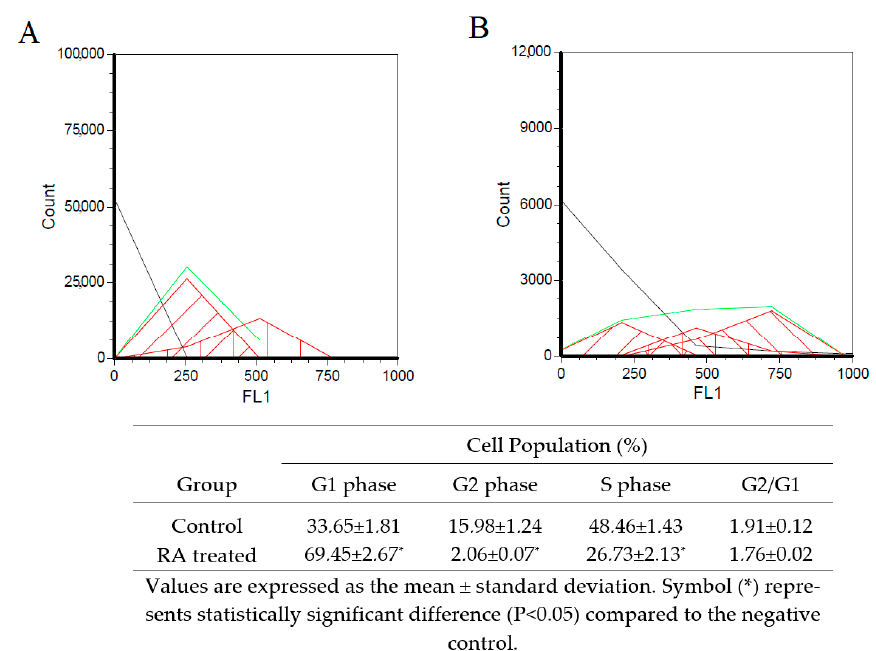
Figure 6. Cell cycle analysis of differentiated SH-SY5Y cells after 11 days of the retinoic acid applica- tion. ( A )—Control (untreated SH-SY5Ycell culture) and ( B )—RA treated cell